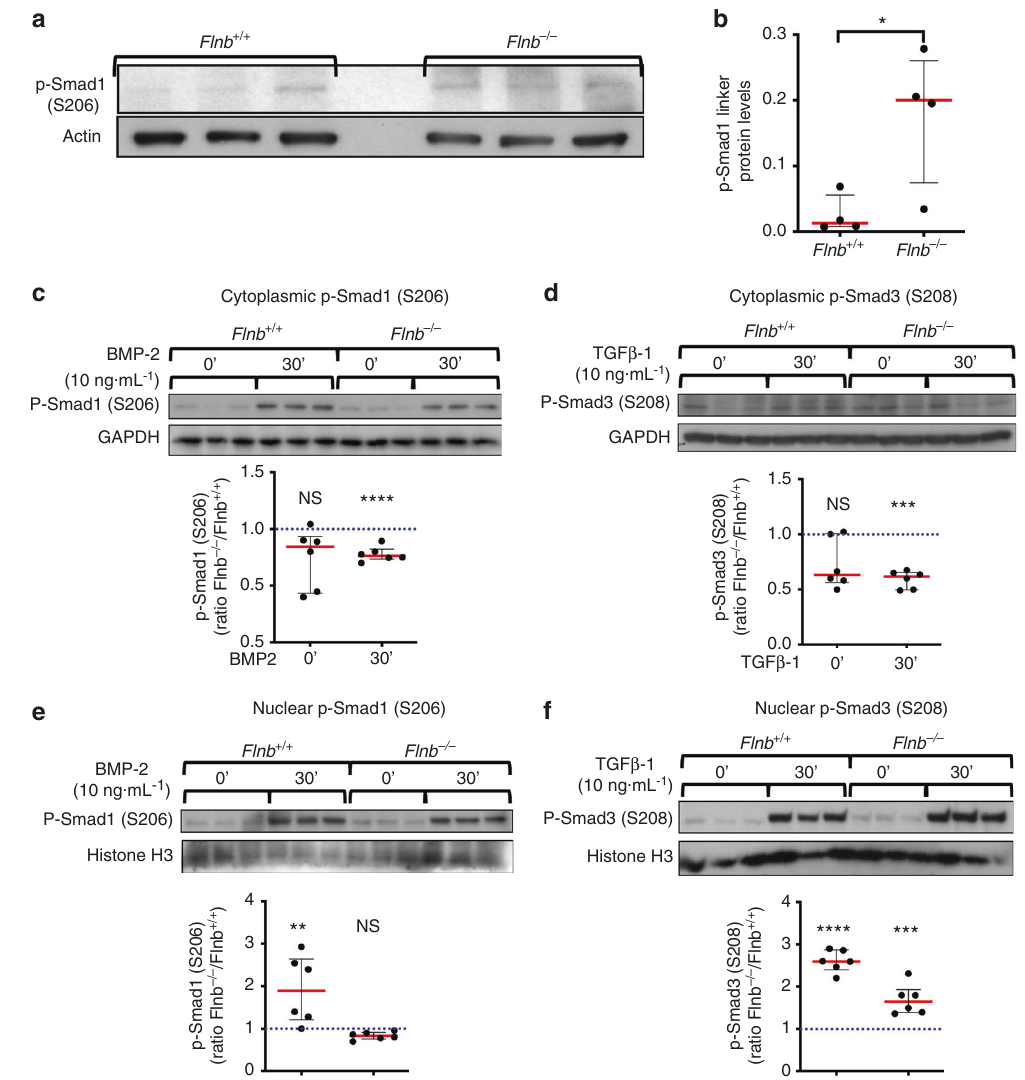
Fig. 3 Higher levels of linker phosphorylated Smads 1 and 3 were found in the nucleus of Flnb − / − primary chondrocytes. a Western blot of Smad 1 linker phosphorylation levels in protein lysates isolated from Flnb + / + and Flnb − / − IVDs. b Quanti fi cation of Western blot normalized to Actin levels showing a signi fi cant increase in Smad 1 linker phosphorylation. n = 3 (each data point contains six IVDs dissected from the thoracic area from a single mouse), NS not signi fi cant, * P value < 0.05. c – f Above: Western blots of Flnb + / + and Flnb − / − cytoplasmic and nuclear protein lysate fractions isolated from primary sternal chondrocytes unstimulated and stimulated with 5 ng·mL − 1 TGF β -1 ligand and 10 ng·mL − 1 BMP-2 ligand for 30 min probed with antibodies against Smad 3 linker phosphorylation at the S208 residue, Smad 1 linker phosphorylation at the S206 residue, GAPDH, and histone H3. Below: Quanti fi cation of TGF β -1- and BMP-2-stimulated Western blots normalized against GAPDH (cytoplasmic fractions) and histone H3 (nuclear fractions) levels. The results showed a signi fi cant decrease in linker phosphorylated Smad 3 and Smad 1 levels in cytoplasmic fractions but a signi fi cant increase in nuclear fractions of Flnb − / − primary chondrocytes. n = 6 (All data points represent biological replicates of Flnb − / − protein lysates, each normalized to a Flnb + / + control. The dotted blue line in each graph represents the Flnb + / + protein level, which is set to 1 upon normalization. Signi fi cance is determined by comparing Flnb − / − to Flnb + / + ), NS not signi fi cant, * P < 0.05, ** P < 0.01, *** P <